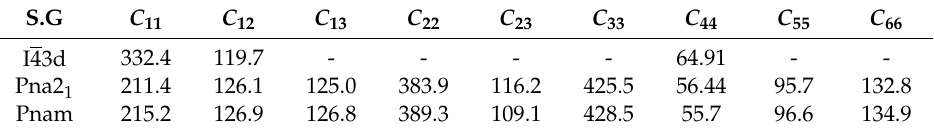
Table 5. Elastic stiffness constants C ij (GPa) of Zr 3 N 4 .